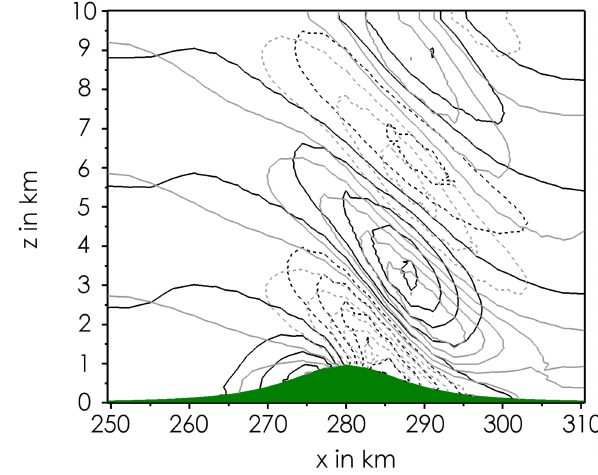
Figure 18. Vertical cross section ( x – z plane) of vertical wind speed for the RH95 case (black) and the RH50 case (grey). Updrafts in solid lines (0.2m s − 1 contour interval, zero line included), downdrafts in dashed lines (0.2m s − 1 contour interval, zero line excluded).